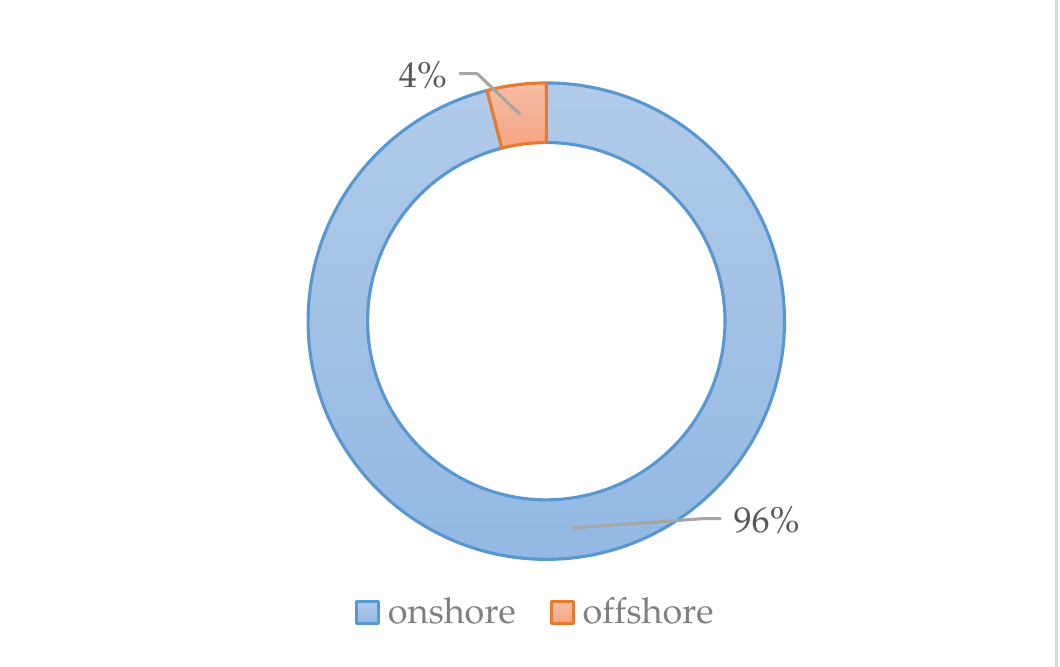
ff shore wind turbine installations in global wind capacity Figure 3. Onshore and offshore wind turbine installations in global wind capacity [26]. Figure 3. Onshore and o